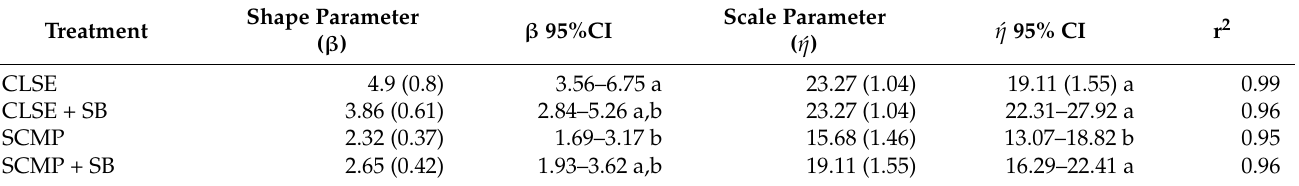
Table 5. Results of the shear bond strength test with Weibull